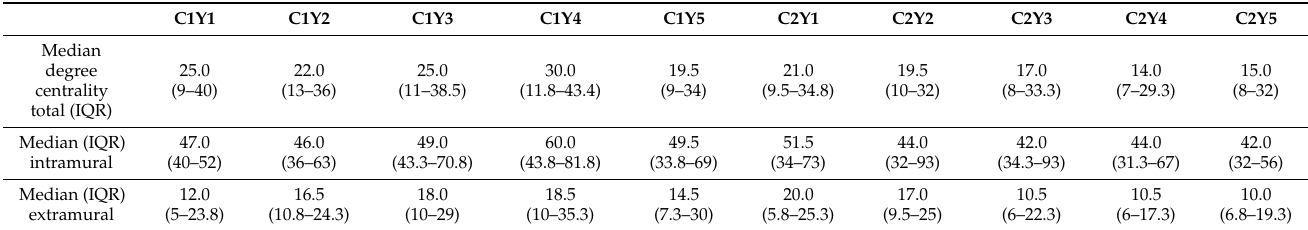
Table 6 . Degree centrality measures of the NEC network over ten years (IQR = interquartile range).